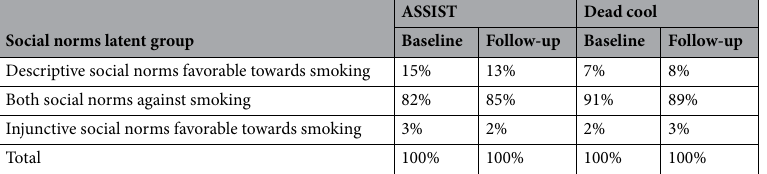
Table 1. The proportion of participants aggregated for both settings belonging to each latent group by intervention according to the Latent Transition Analysis.